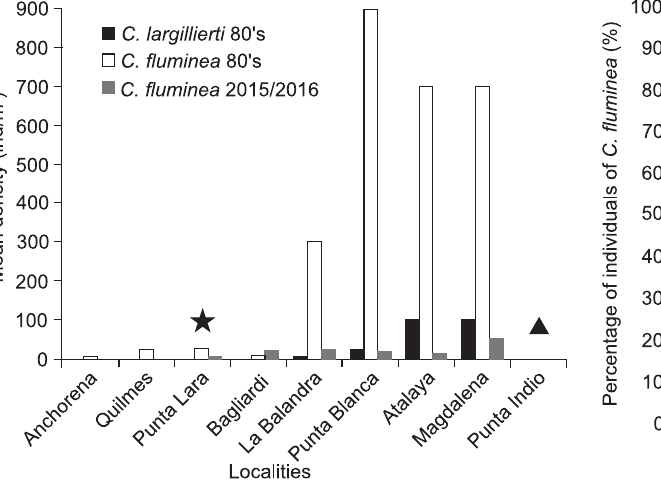
Figure 2. Corbicula spp. mean density at sampled localities and previous density values for the same localities (Darrigran 1992b). (  ) Presence of C. largillierti in 80’s; (  ) sporadic presence of C. fluminea in 80’s.